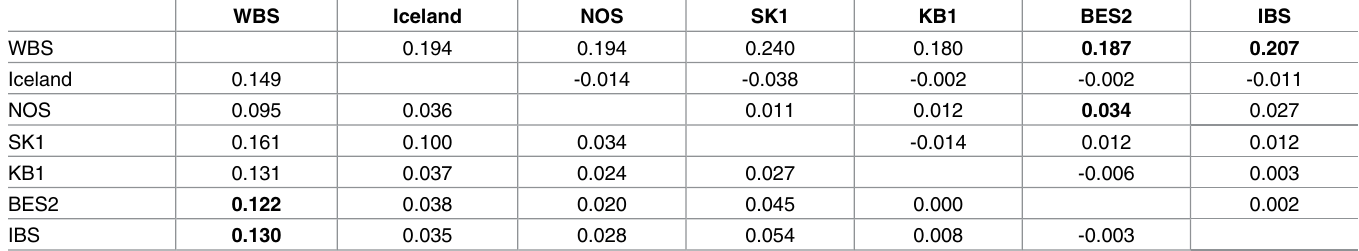
Table 3. Pairwise F ST values for the SNP marker-set (672 SNPs; above the diagonal) and for the microsatellite marker-set (below the diagonal). Values in bold are significant followingthe Holm-Bonferroni correction at an experiment-wise error rate of α = 0.05.